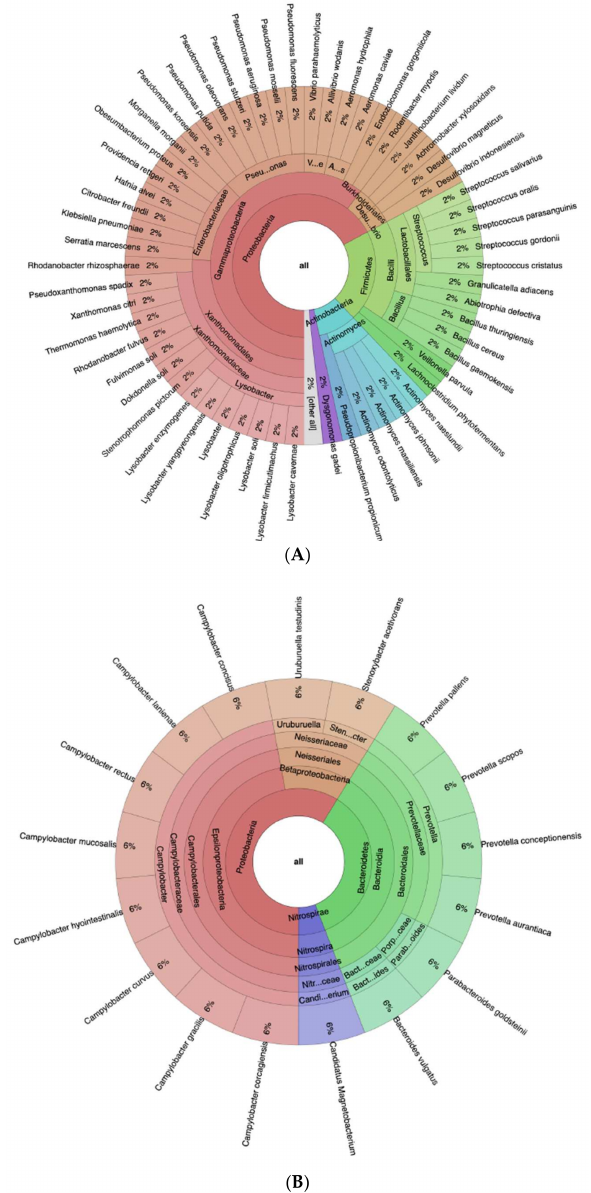
Figure 3. Krona plots of the taxonomies of the organisms which resulted in differentially abundant in the NGS analysis between the CG and NG groups. ( A ) Species overabundant in the CG group. ( B ) Species overabundant in the NG group. The full taxonomy of each species was reconstructed using the R package myTAI with the itis and NCBI